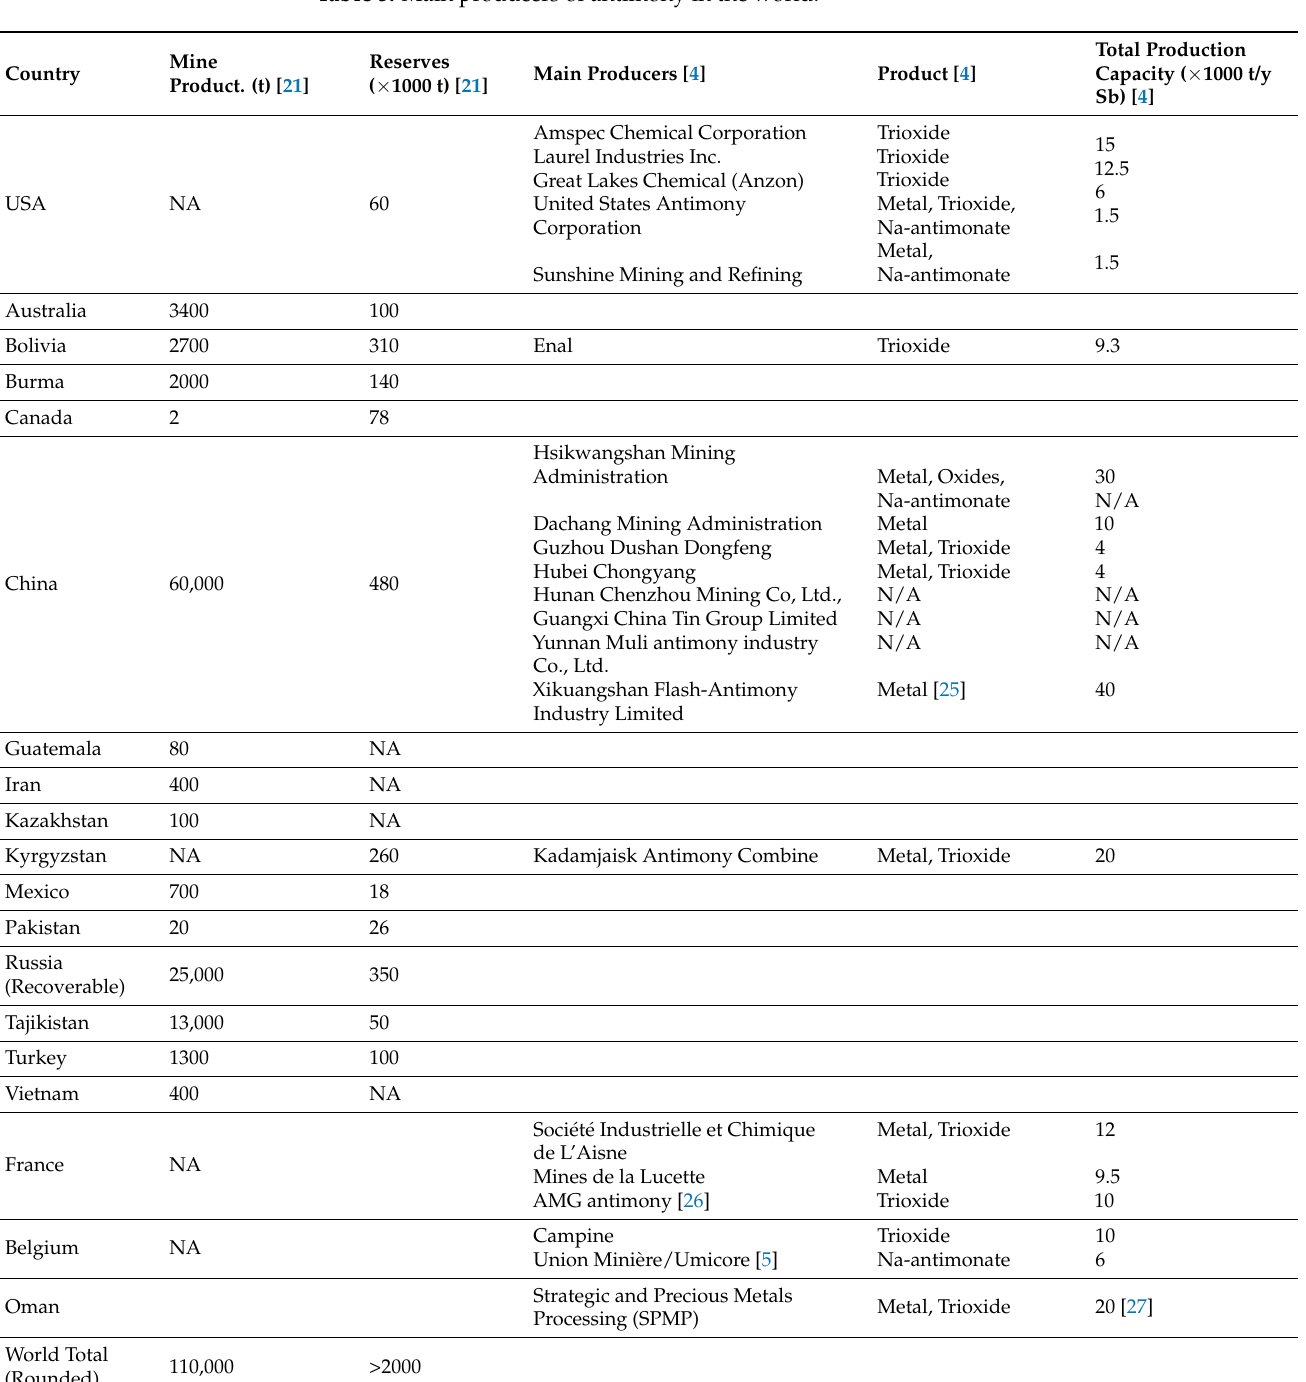
Table 5. Main producers of antimony in the